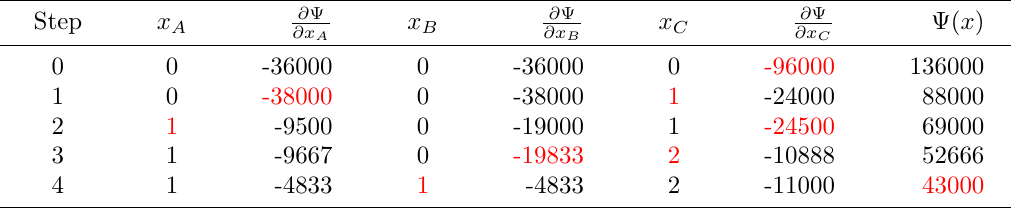
Table 1: Verification and examination management applied to find an effective sequence of examination for the subsystems A, B, C . The table shows the proposed sequence of examination calculated from a steepest decent approach. The red numbers illustrate the information used for selecting examination. The resulting examination effort becomes: ( x A = 1 , x B = 1 , x C =